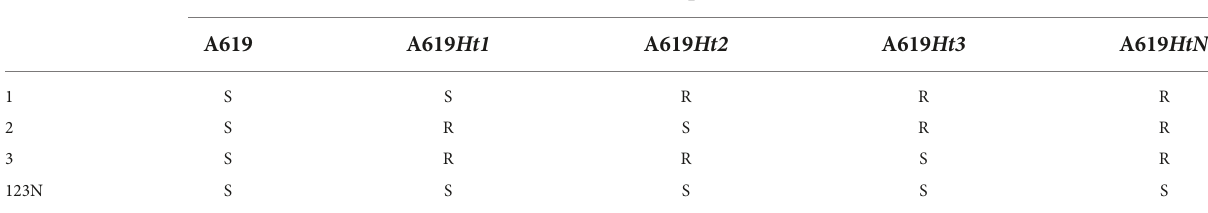
TABLE 1 Virulence testing on the five different Ht genes by designating physiological races of Exserohilum turcium . Race